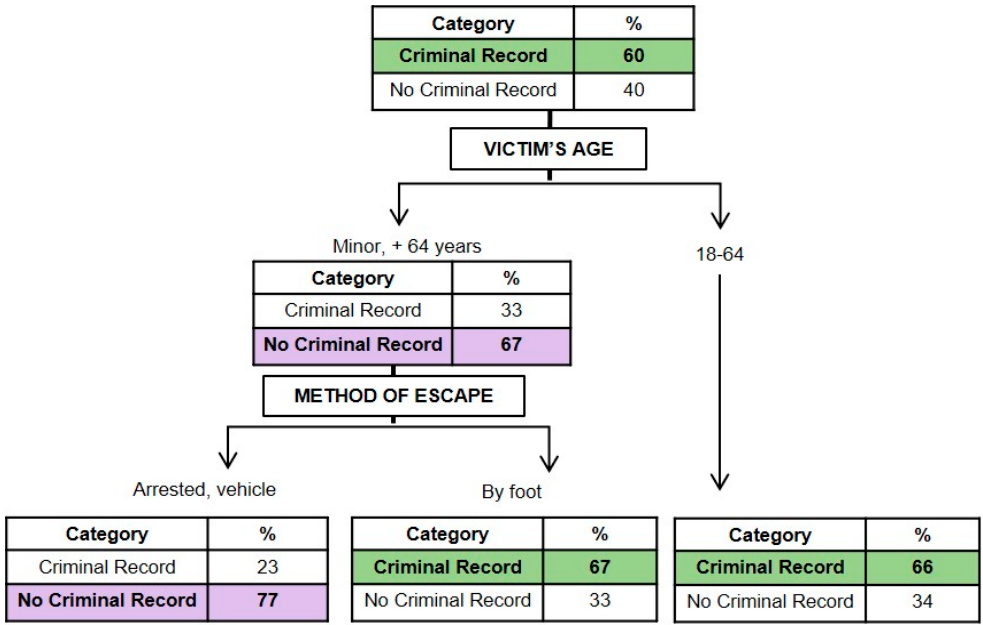
Figure 4. Graphical representation of the classification tree for the perpetrator’s criminal record history.